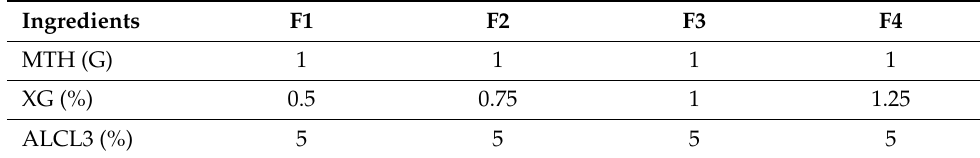
Table 1. Composition matrix of the xanthan gum